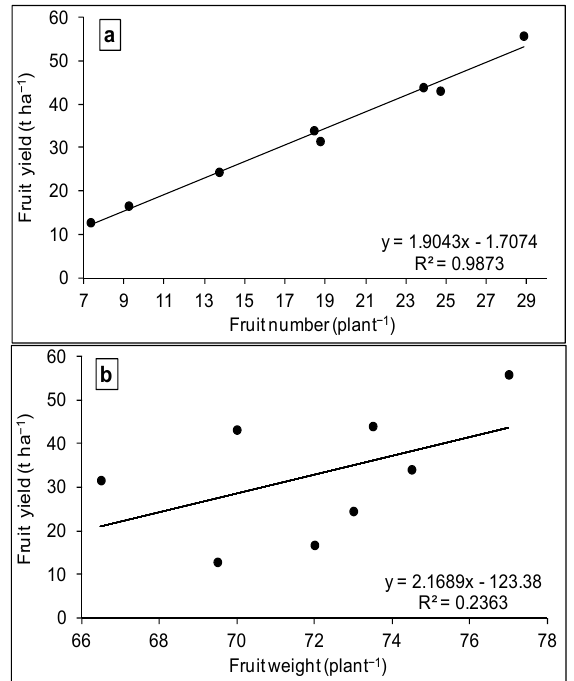
Figure 1. Relationship between the total fruit yield and fruit number per plant ( a ), and total fruit yield and average fruit weight per plant ( b ), of eggplant subjected to varying water stress and AM inoculation.